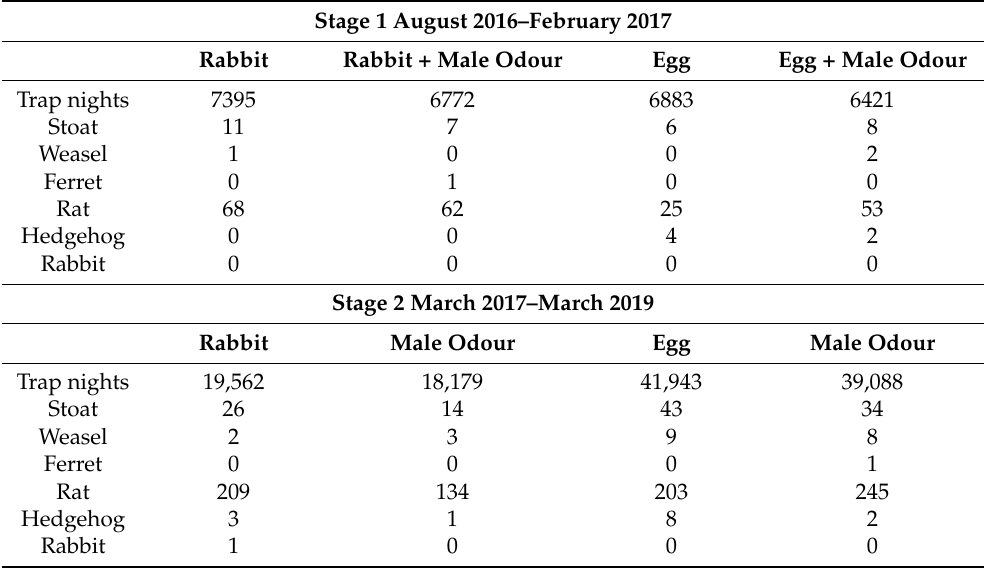
Table 5. Captures of stoats, other predators and non-target species on dried rabbit meat, hen egg and/or male stoat bedding lure during the field trials at Coromandel, 2016–2019. Stage 1 tested the food lure against a combination of scent lure and food lure. In Stage 2, the scent lure was tested on its own against the food lure. The two food lures were used during different monthly trapping periods on the various trapping lines. Total trap nights are shown for each lure